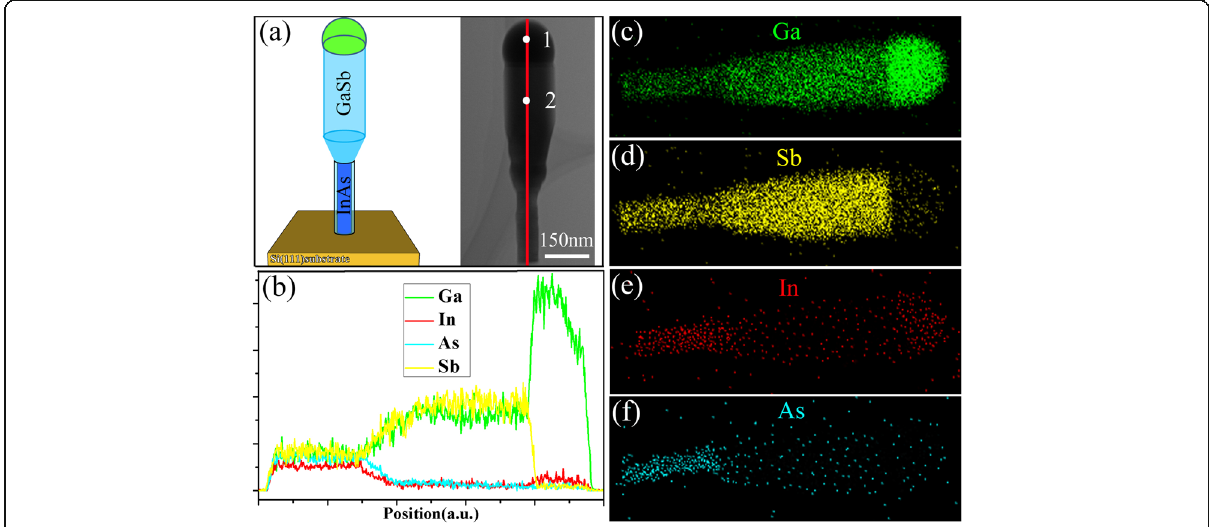
Fig. 6 a The illustration of the axial InAs/GaSb heterostructure nanowires and a low-magnification TEM image of a grown InAs/GaSb nanowire grown at 520 °C. b EDS line scan along the red line marked in ( a ). c – f EDS compositional maps of the nanowire in ( a ), showing the Ga, Sb, In, and As distribution. Two spots in a mark the positions where EDS point analyses were